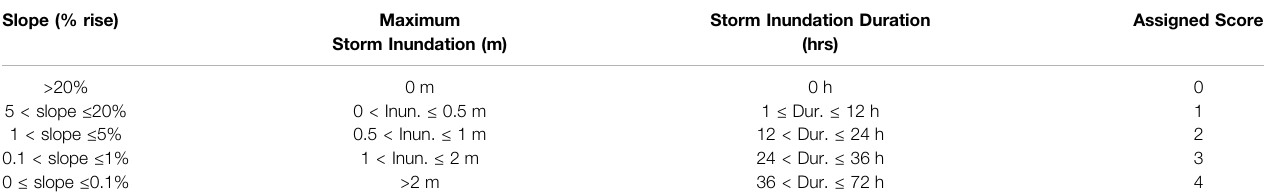
TABLE 2 | Categories for slope, maximum storm inundation, and storm inundation duration, and the assigned score for each. A score of 0 re fl ects the lowest likelihood of marsh migration while a score of 4 represents the highest likelihood based on these three factors. Slope (% rise)